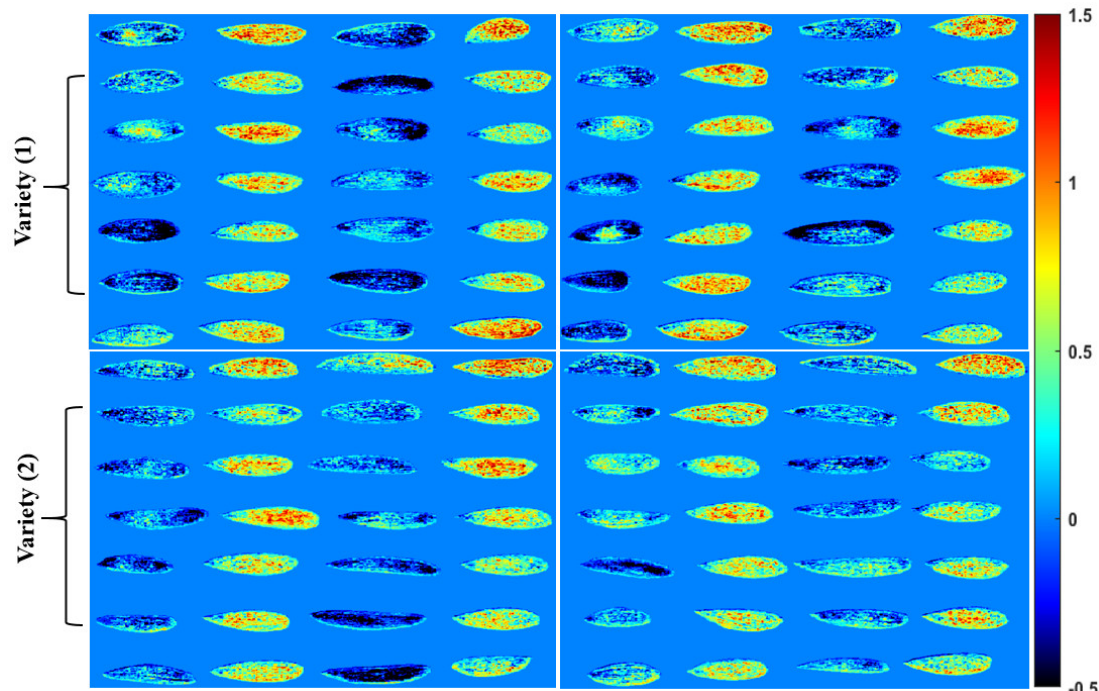
Figure 9. Discrimination mapped images of the PLS-DA model, easily visualizing the chemical composition of adulterated seeds of both seed varieties.